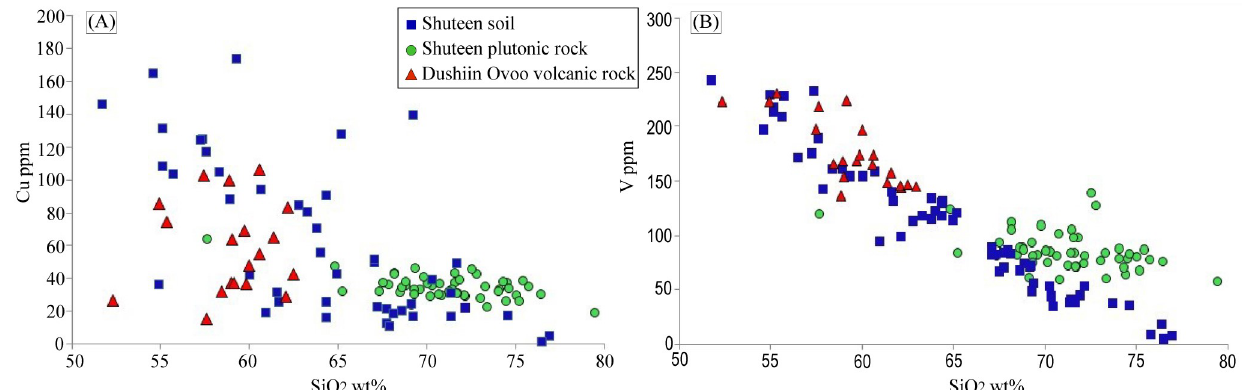
Fig. 8. Correlation of selected heavy metals (Cu and V) concentration between rock and soil, in the Shuteen